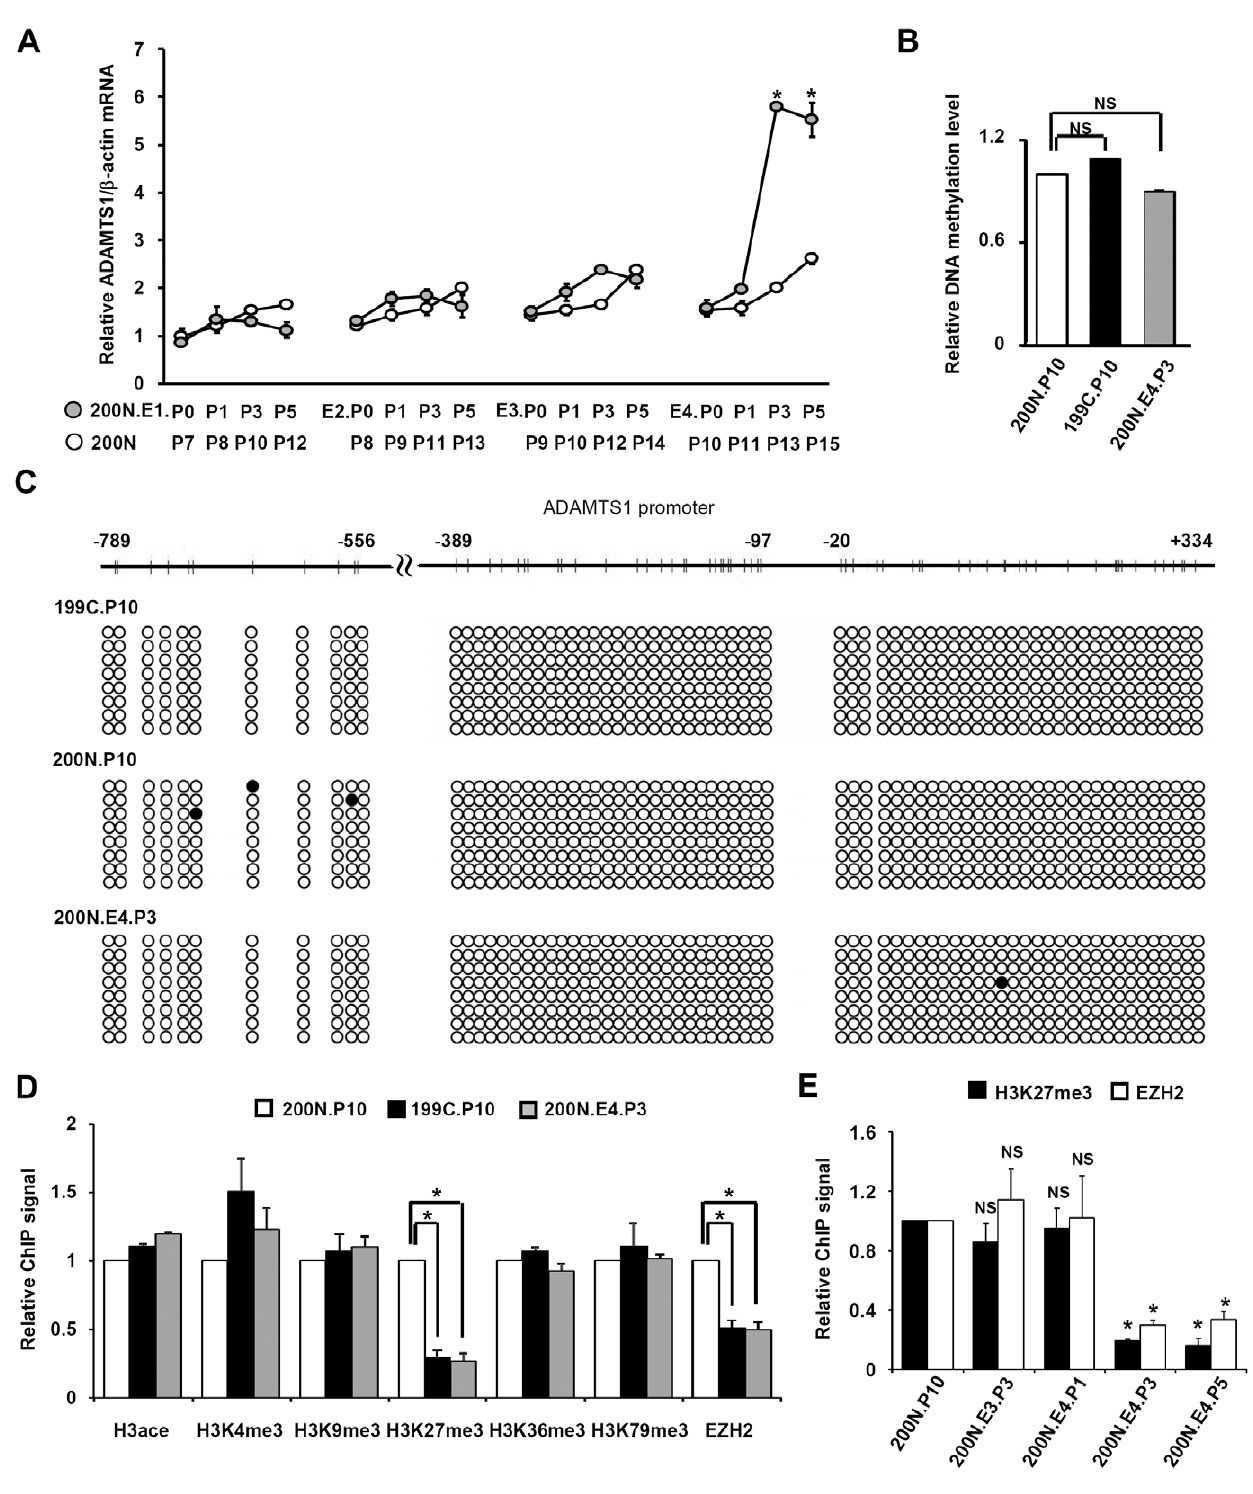
Figure 5. Increase of ADAMTS1 mRNA correlated with reduction of ADAMTS1 promoter-associated H3K27me3 and EZH2 binding through passages. (A) ADAMTS1 mRNA levels in indicated NAF derivatives were analyzed and shown gradually increased in NAF 200N.E4 from P0 to P3 and maintained from P3 to P5. (B) MeDIP indicates that ADAMTS1 promoter-associated DNA methylation level was similar in NAF 200N.P10, CAF 199C.P10 and NAF 200N.E4.P3 cells. (C) Bisulfite sequencing indicates that ADAMTS1 promoter in CAF 199C.P10, NAF 200N.P10 and NAF 200N.E4.P3 cells was hypomethylated. Closed circle: methylated cytosine. (D) ADAMTS1 promoter-associated H3K27me3 and EZH2 binding was decreased in CAF 199C.P10 and NAF 200N.E4.P3 cells. (B and D) MeDIP (B) or ChIP assays (D) using antibody against H3ace, H3K4me3, H3K9me3, H3K27me3, H3K36me3, H3K79me3 or EZH2 was performed in NAF 200N.P10 (white bars), CAF 199C.P10 (black bars) and NAF 200N.E4.P3 (gray bars) cells, followed by real-time PCR analysis. (E) ADAMTS1 promoter-associated H3K27me3 and EZH2 binding were decreased in NAF 200N.E4.P3 and maintained through passages to NAF 200N.E4.P5. ChIP assays using antibody against H3K27me3 (black bars) or EZH2 (white bars) were performed in